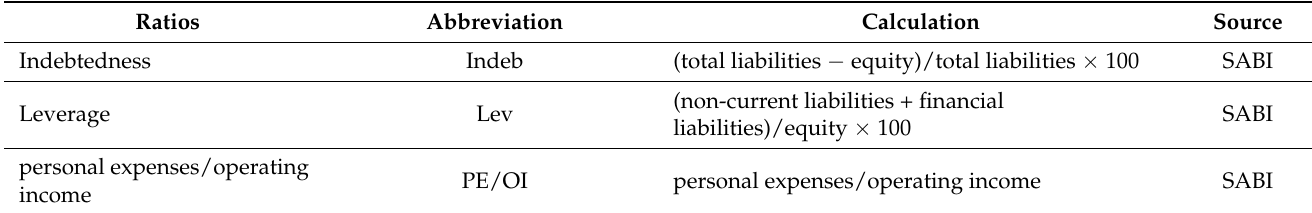
Table A1. Variables